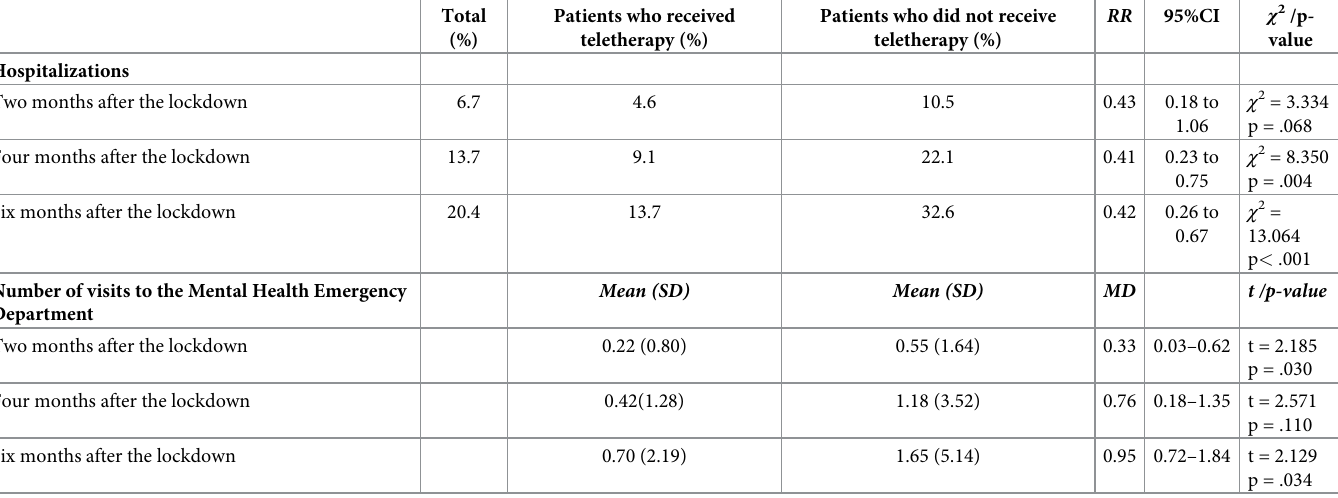
Table 3. Hospitalizations and emergency visits two, four and six months after the lock